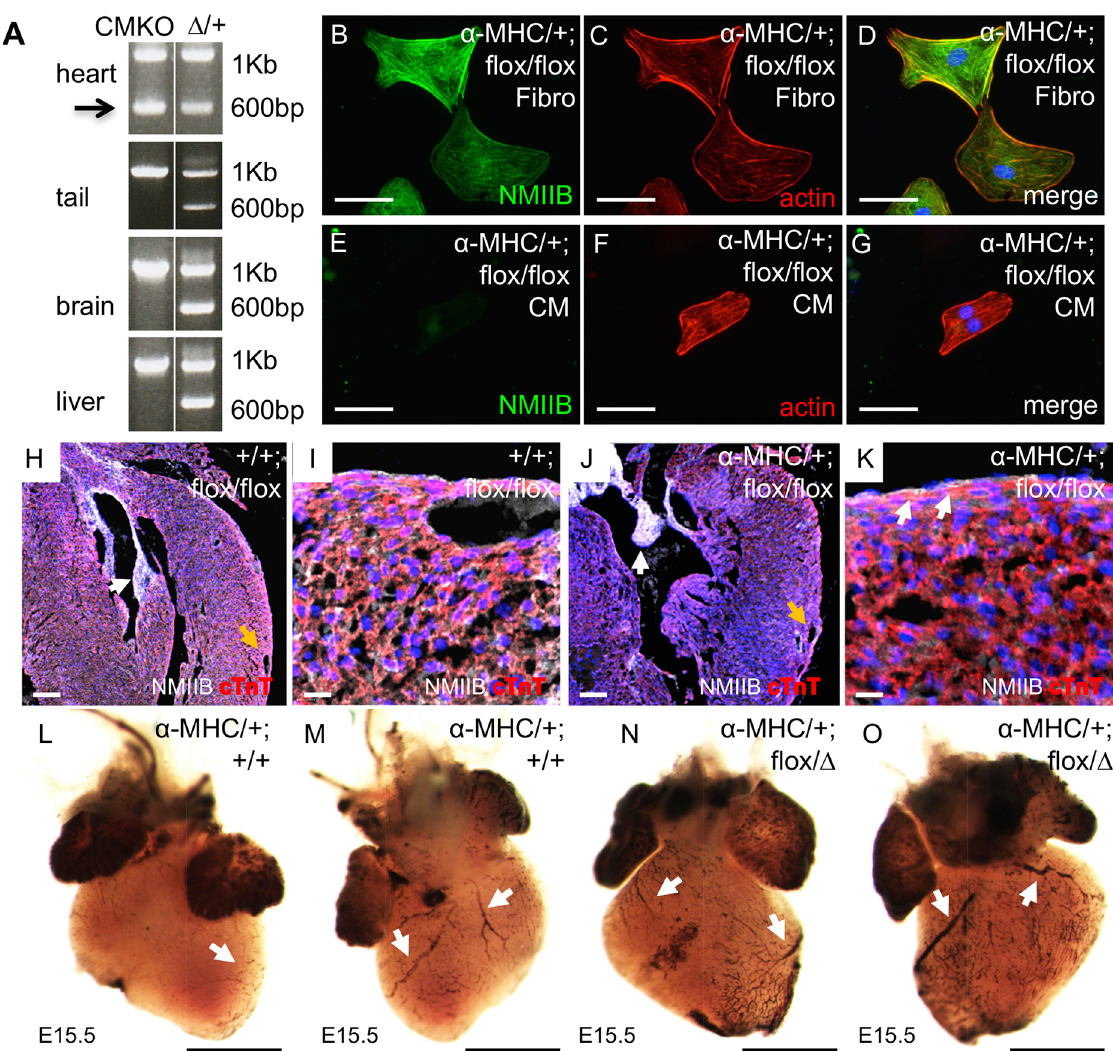
Fig 6. NMHC IIB is not required in cardiomyocytes for coronary vessel formation. A: Genomic PCR on tissues isolated from mice carrying the α MHC-Cre transgeneand Myh10 flox/+ allelesshows a PCR product of 600 bp in cardiac tissue, consistent with deletionof Myh10 exon 2 from the genome (arrow). This product is not seen in tail, brain, or liver tissue. PCR results from a Myh10 Δ /+ heterozygous animalare shownfor the correspondingtissues, with the 600 bp product present in all tissues. The 1 Kb product represents the Myh10 allelelackingexon 2 deletion.Products were sequencedto confirm specificity of PCR reactions. B: NMHC IIB protein (green) and C: actin (red; phalloidinstain) localisationin fibroblasts culturedfrom α MHC-Cre; flox/flox hearts. D: Mergedimage shows DAPI labelingof nuclei(blue). E: NMHC IIB protein (green) and F: actin (red; phalloidinstain) localisation in cardiomyocytes cultured from α MHC-Cre; flox/flox hearts. G: Mergedimage shows DAPI labellingof nuclei (blue). H: Expression patterns of NMHC IIB (white) and cardiac Troponin T (red), and nucleistained with DAPI (blue) in α MHC-Cre; Myh10+/+ control embryo with presence of coronary vessel (orangearrow). NMHC IIB expressionis seen throughout heart includingvalve tissue (white arrow). Co-expression of NMHC IIB and cTnT appearspink. I: Highermagnification image of cardiactissue from α MHC-Cre; Myh10+/+ control embryo. J: Expression patterns of NMHC IIB (white) and cardiacTroponinT (red), and nuclei stainedwith DAPI (blue) in α MHC-Cre; Myh10 flox/flox control embryo with presence of coronary vessel (orangearrow). NMIIB expressionis seen in valve tissue (white arrow) but reducedin myocardialregionof heart, and is absent from cTnT positive cells, so that the pink stainingindicatingNMHC IIB and cTnT co-expression is reducedin the myocardium. K: Higher magnification image of cardiac tissue from α MHC-Cre; Myh10 flox/flox control embryo. Epicardialexpressionof NMHC IIB persists (white arrows). L: Ventral view of cardiac surface stainedwith DAB to identify blood cells in α MHC-Cre; Myh10+/+ heart (arrow). M: Dorsal view of cardiacsurface stainedwith DAB to identify blood cells in α MHC-Cre; Myh10+/+ heart (arrows). N: Ventral view of cardiacsurface stained with DAB to identify blood cells in α MHC-Cre; Myh10 flox/ Δ heart (arrows). O: Dorsal view of cardiac surface stainedwith DAB to detect endogenousperoxidase activity from blood cells in α MHC-Cre; Myh10+ flox/ Δ heart (arrows). Blood cells within vessels are present on the cardiacsurface of cardiomyocyte-specific Myh10 mutant hearts. Similar results were seen for α MHC-Cre; Myh10 flox/flox hearts. Scale bars: B-G = 50 μ m, H and J = 100 μ m, I and K = 15 μ m, L-O = 400 μ